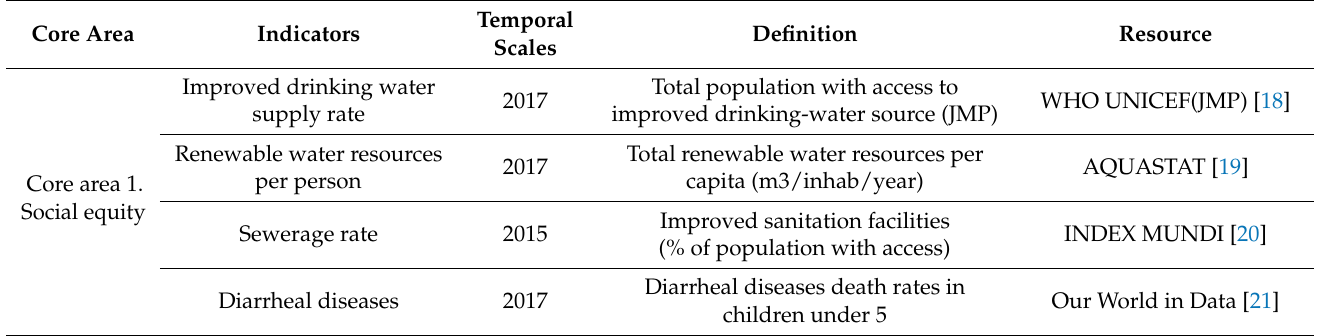
Table 1. Core area 1: indicators and variables of social equity.